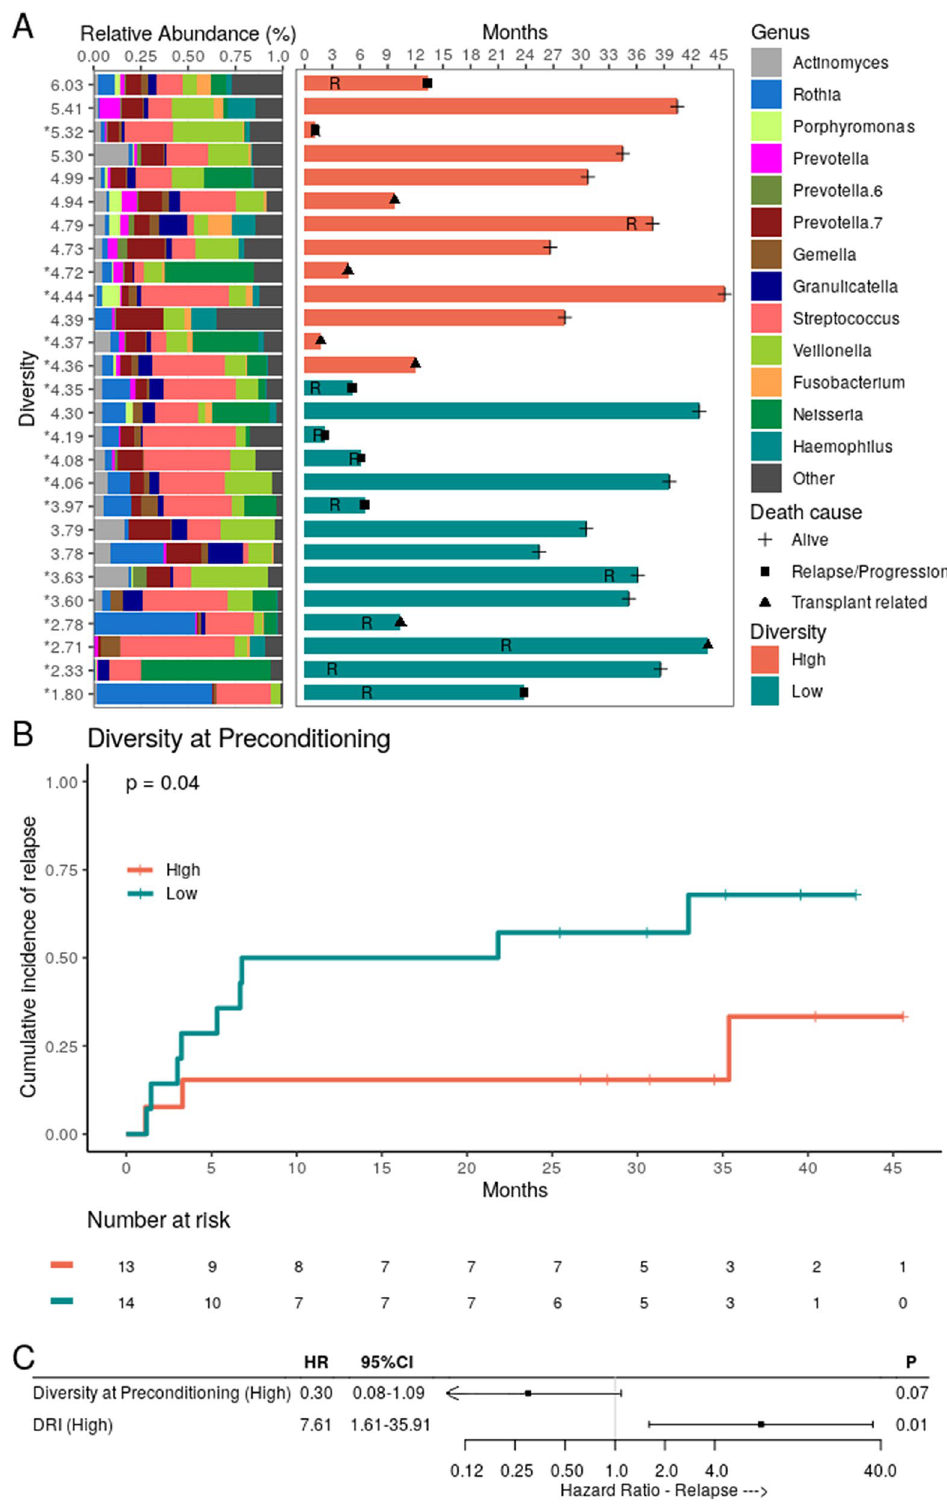
Figure 2. Oral microbiota bacterial dominance and bacterial diversity at preconditioning increased the risk of relapse in patients who underwent allo-HSCT. ( A ) Oral microbiota (OM) composition and diversity at preconditioning and the respective transplant course in each patient (n = 27). Patients are sorted based on descending Shannon diversity index, with the measures shown in the left subplot y-axis. The asterisk in the Shannon index indicates patients with at least one dominant (relative abundance > 30%) genus at preconditioning. Only genera showing relative abundance ≥ 30% in at least one preconditioning sample or relative abundance ≥ 5% in at least 10% of preconditioning samples are shown. Relevant outcomes (relapse and death) after infusion (aplasia) are shown in a timeline (in months) subplot (right). The plus sign represents censoring. R relapse. ( B ) Cumulative incidence of relapse with patients (n = 27) stratified by OM bacterial diversity at preconditioning (high versus low). ( C ) The DRI-adjusted hazard ratio for the association of OM bacterial diversity at preconditioning and relapse (n =